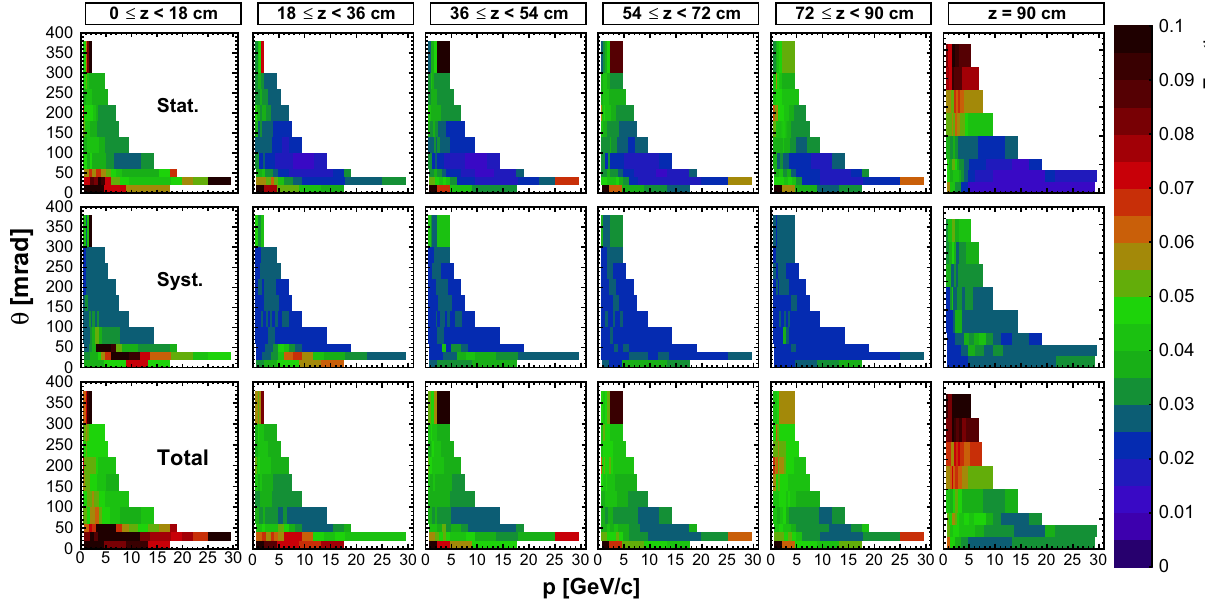
Fig. 20 Uncertainties on K − yields shown as a function of p and θ : statistical uncertainties (top row), total systematic uncertainties (middle row) and total uncertainties (bottom row). Each column corresponds to a different longitudinal bin